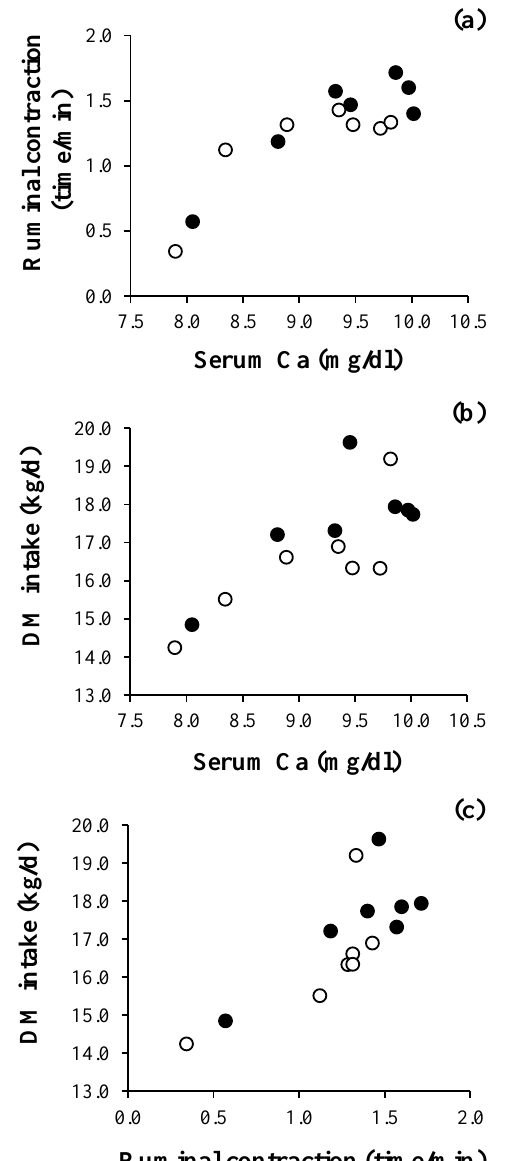
Figure 3. Correlations (a) between average serum calcium (Ca) concentration (mg/dL) and average ruminal contraction